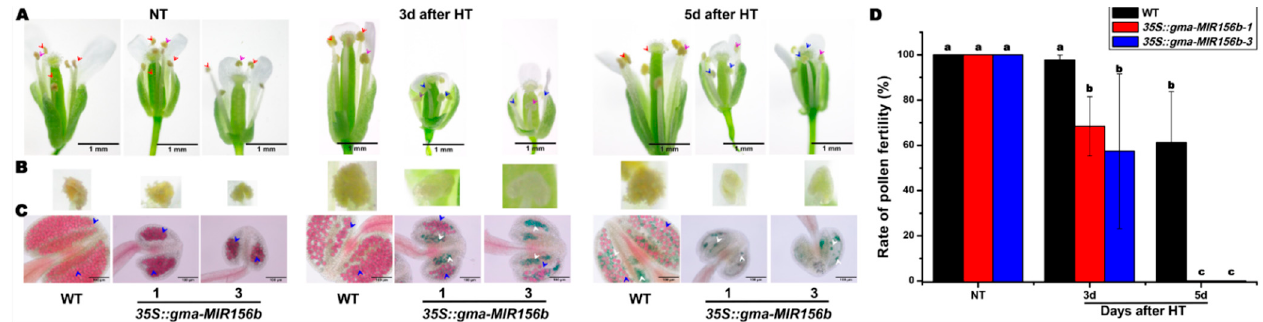
Figure 6. Effect of short-term extremely HT on male fertility in WT and 35S::gma-MIR156b lines of Arabidopsis. ( A ) Phenotype of flowers in WT and 35S:: gma-MIR156b lines after short-term extremely HT stress. The red and blue arrows indicate dehiscent and indehiscent anthers, respectively. Scale bars = 1 mm. ( B ) Phenotype of anthers in WT and 35S: : gma-MIR156b lines after short-term extremely HT stress. An enlarged view of the anthers in ( A ) indicated by pink arrows is shown. ( C ) Pollen fertility in WT and 35S::gma-MIR156b lines after short-term extremely HT stress. The red and green pollens pointed by blue and white arrows indicate fertile and sterile pollens, respectively. Scale bars = 100 µm. ( D ) Calculation of pollen fertility rate in WT and 35S::gma-MIR156b lines after short-term extremely HT stress ( n = 10). Data are presented as means ± SD from independent biological replicates. Values with a different letter indicates statistical differences (one-way ANOVA, Duncan’s test, p < 0.05).